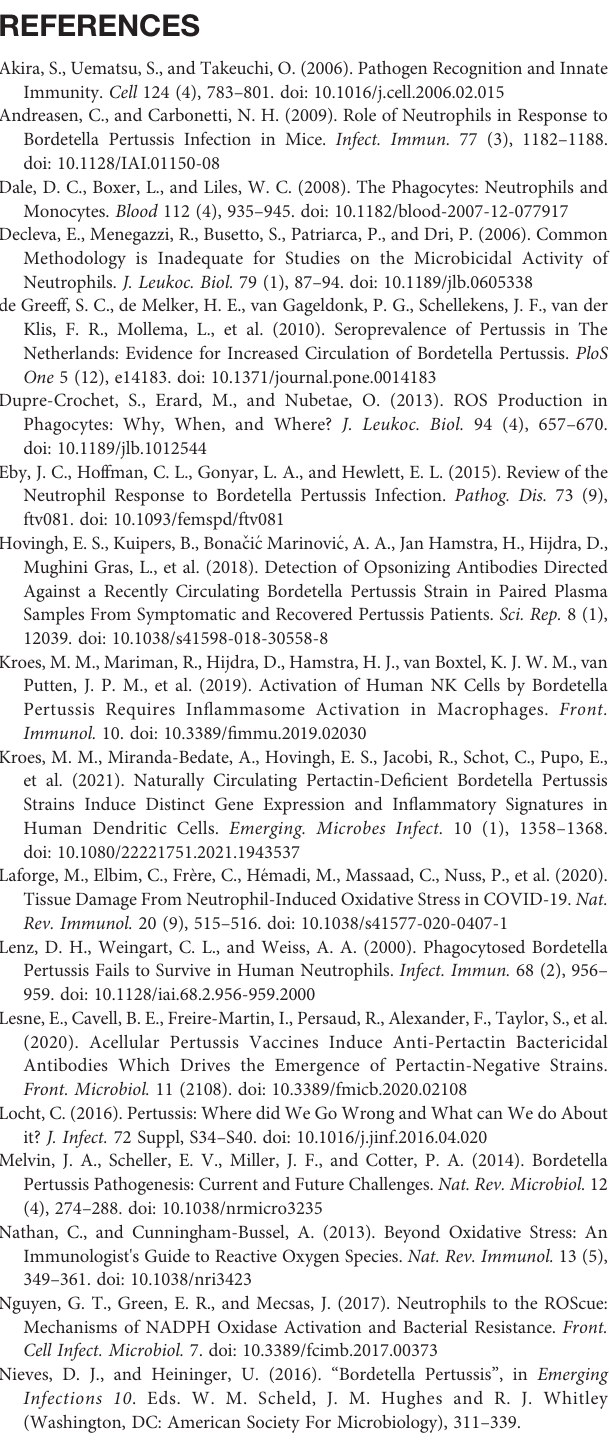
Supplementary Figure 1 | Inhibition of ROS production by the NOX inhibitor. ROS production was measured in real-time for 30 minutes after incubationof neutrophils in the presence or absence of 5 ng/ml PMA, B. pertussis